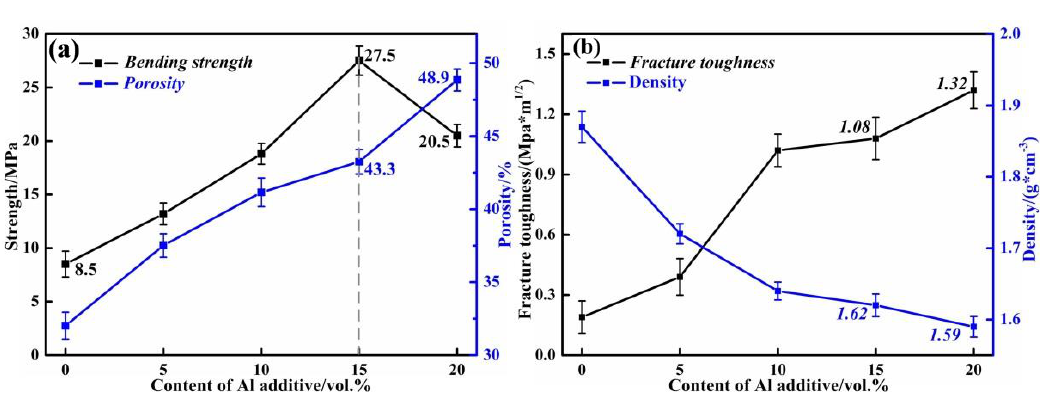
Figure 7. ( a ) High-temperature strength and porosity distribution of SiO 2 ceramic molds; ( b ) Fracture toughness and density distribution of SiO 2 ceramic molds.